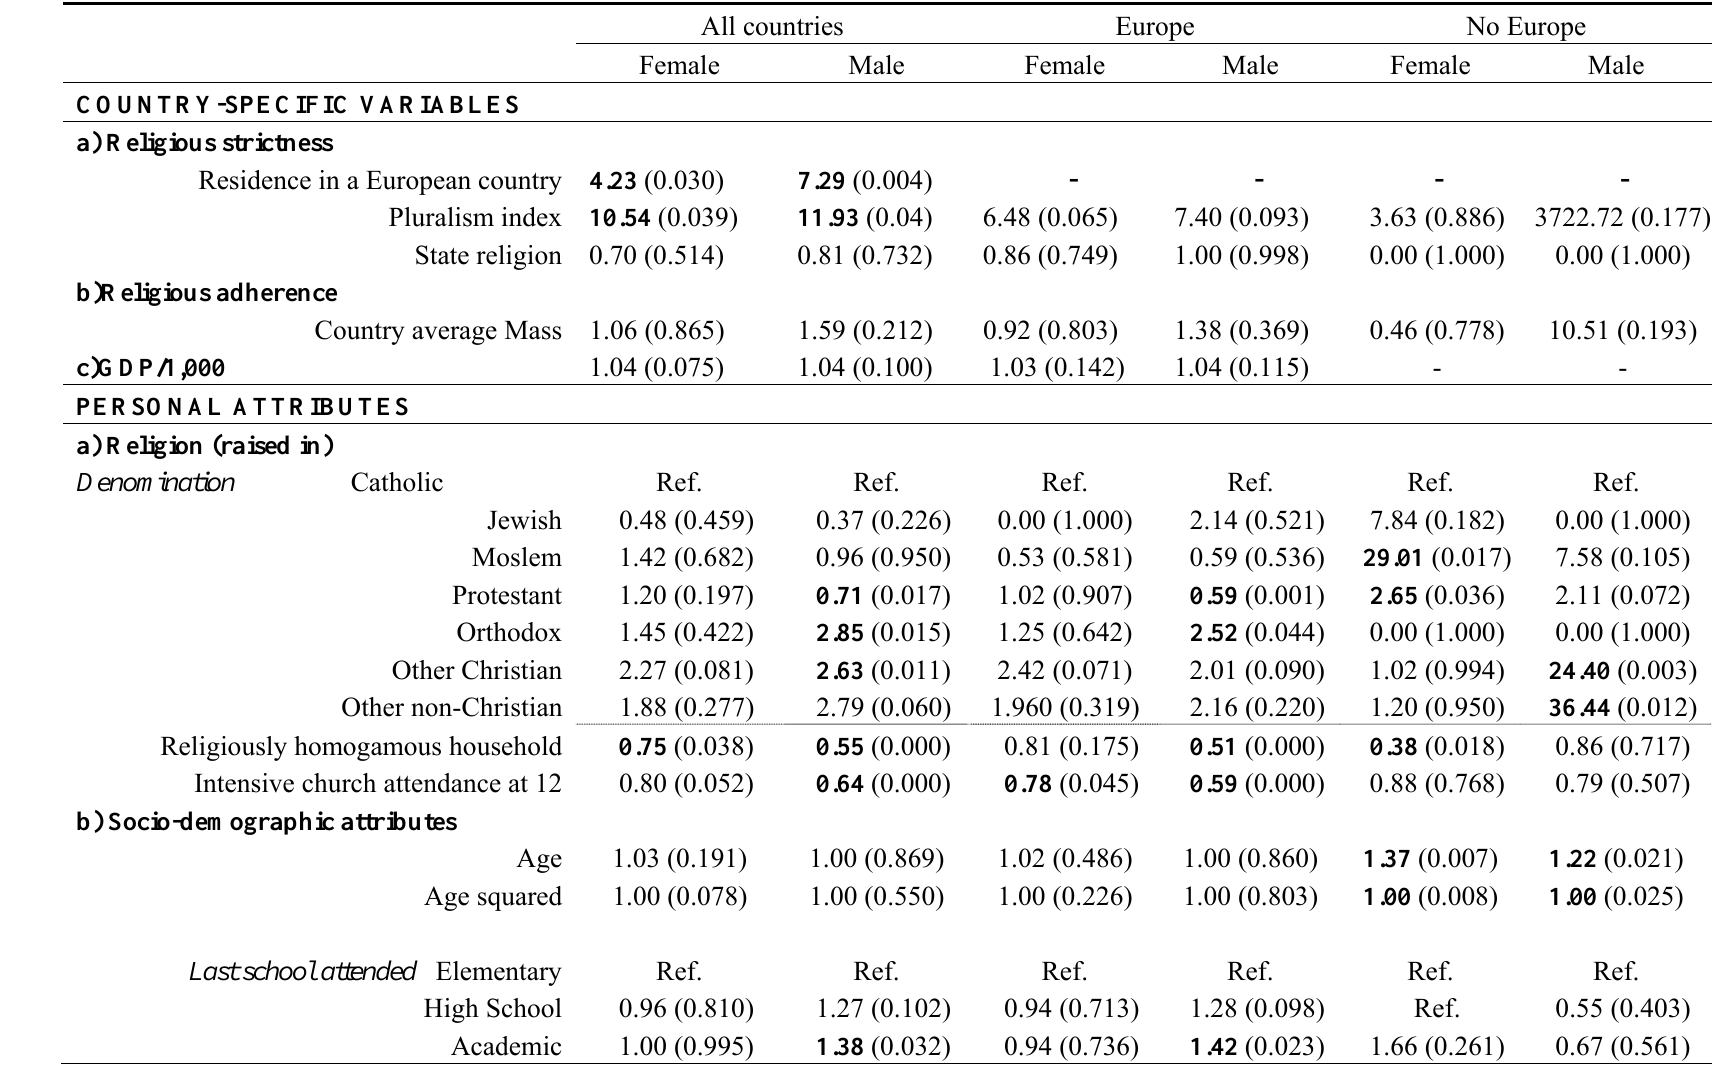
Table 2. Logit regressions of disaffiliation (odds